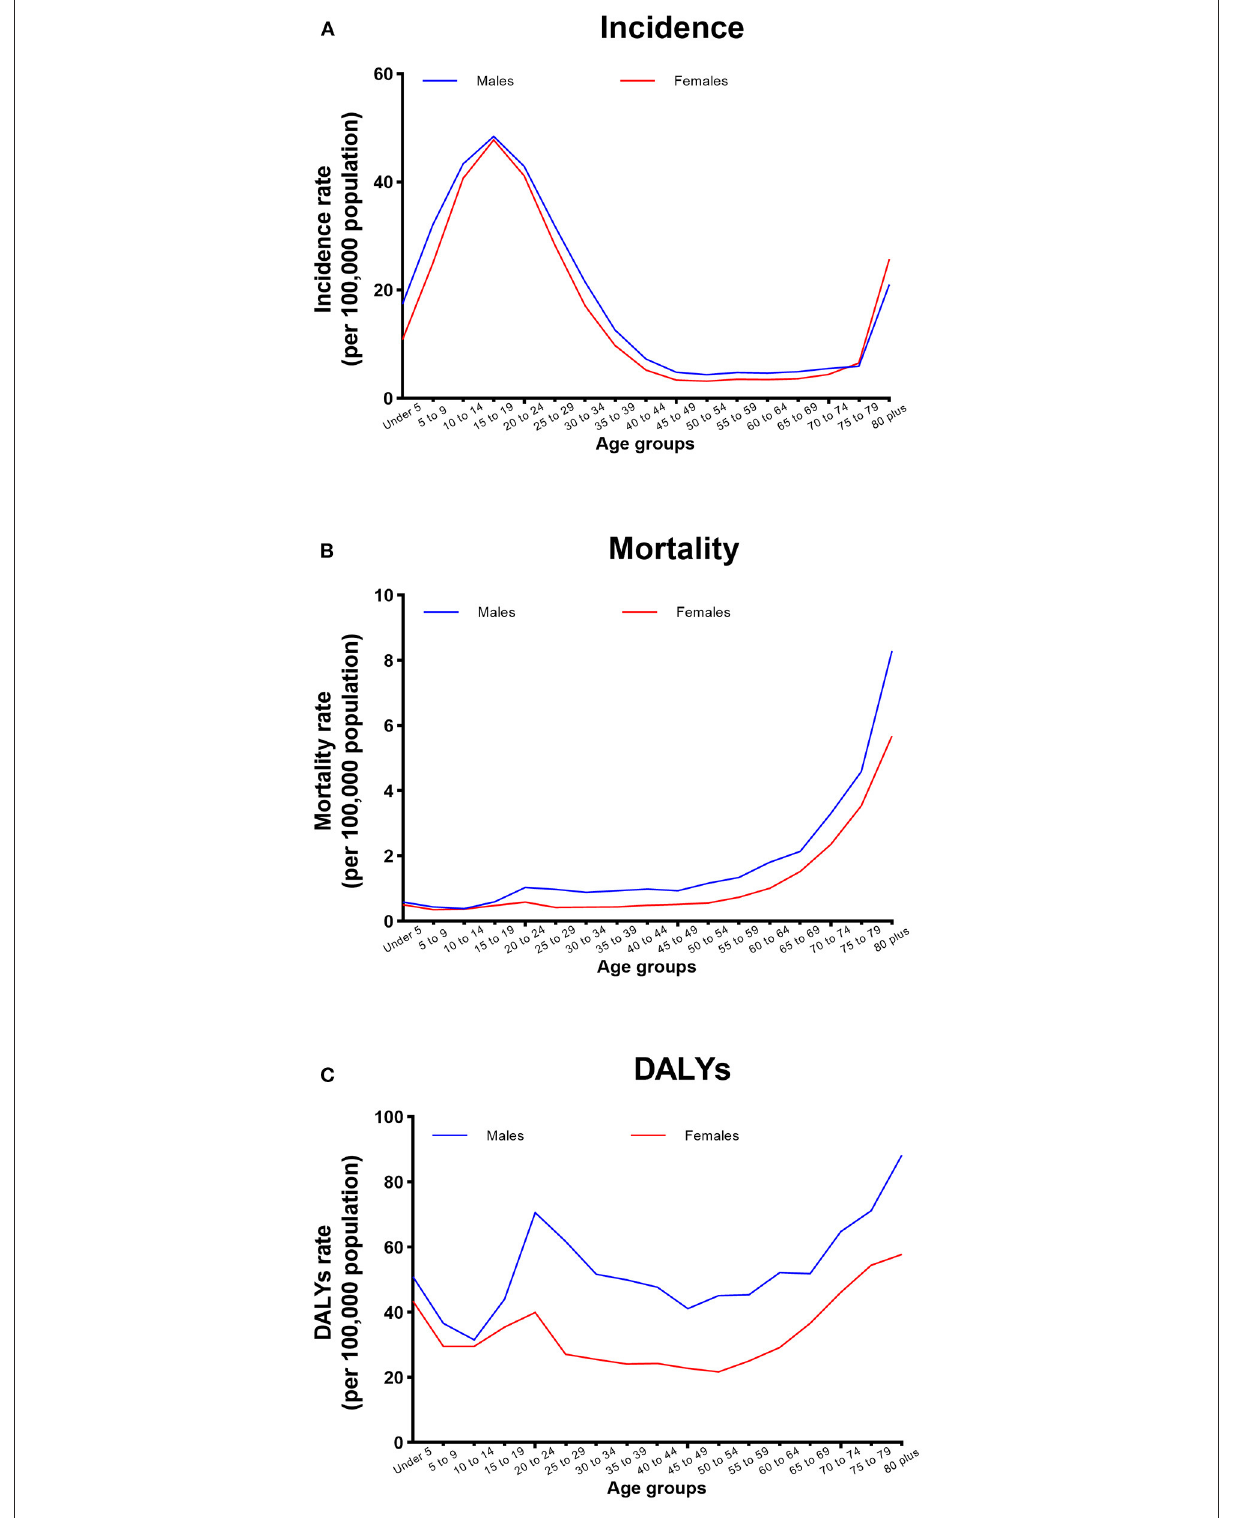
FIGURE2 Sex-specific (A) incidence and (B) mortality rates of CO poisoning and (C) DALYs due to CO poisoning according to age in China in